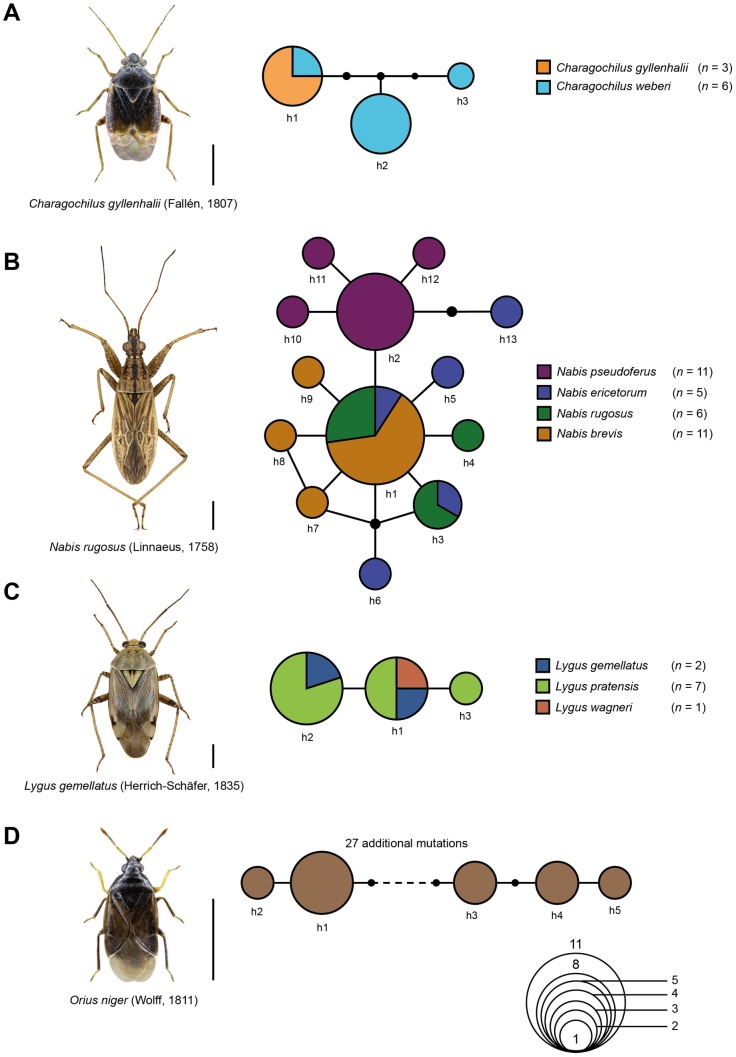
Statistical parsimony networks showing the mutational relationships among the analyzed mitochondrial CO1 haplotypes of A: Charagochilus gyllenhalii and C. weberi, B: Nabis brevis, N. ericetorum, N. pseudoferus, and N. rugosus, C: Lygus gemellatus, L. pratensis, and L. wagneri, and D: Orius niger.Each line in the network represents a single mutational change; small black dots indicate missing haplotypes. The numbers of analyzed specimens (n) are listed, while the diameter of the circles is proportional to the number of haplotypes sampled (see given Open circles with numbers). Scale bars  = 1 mm.